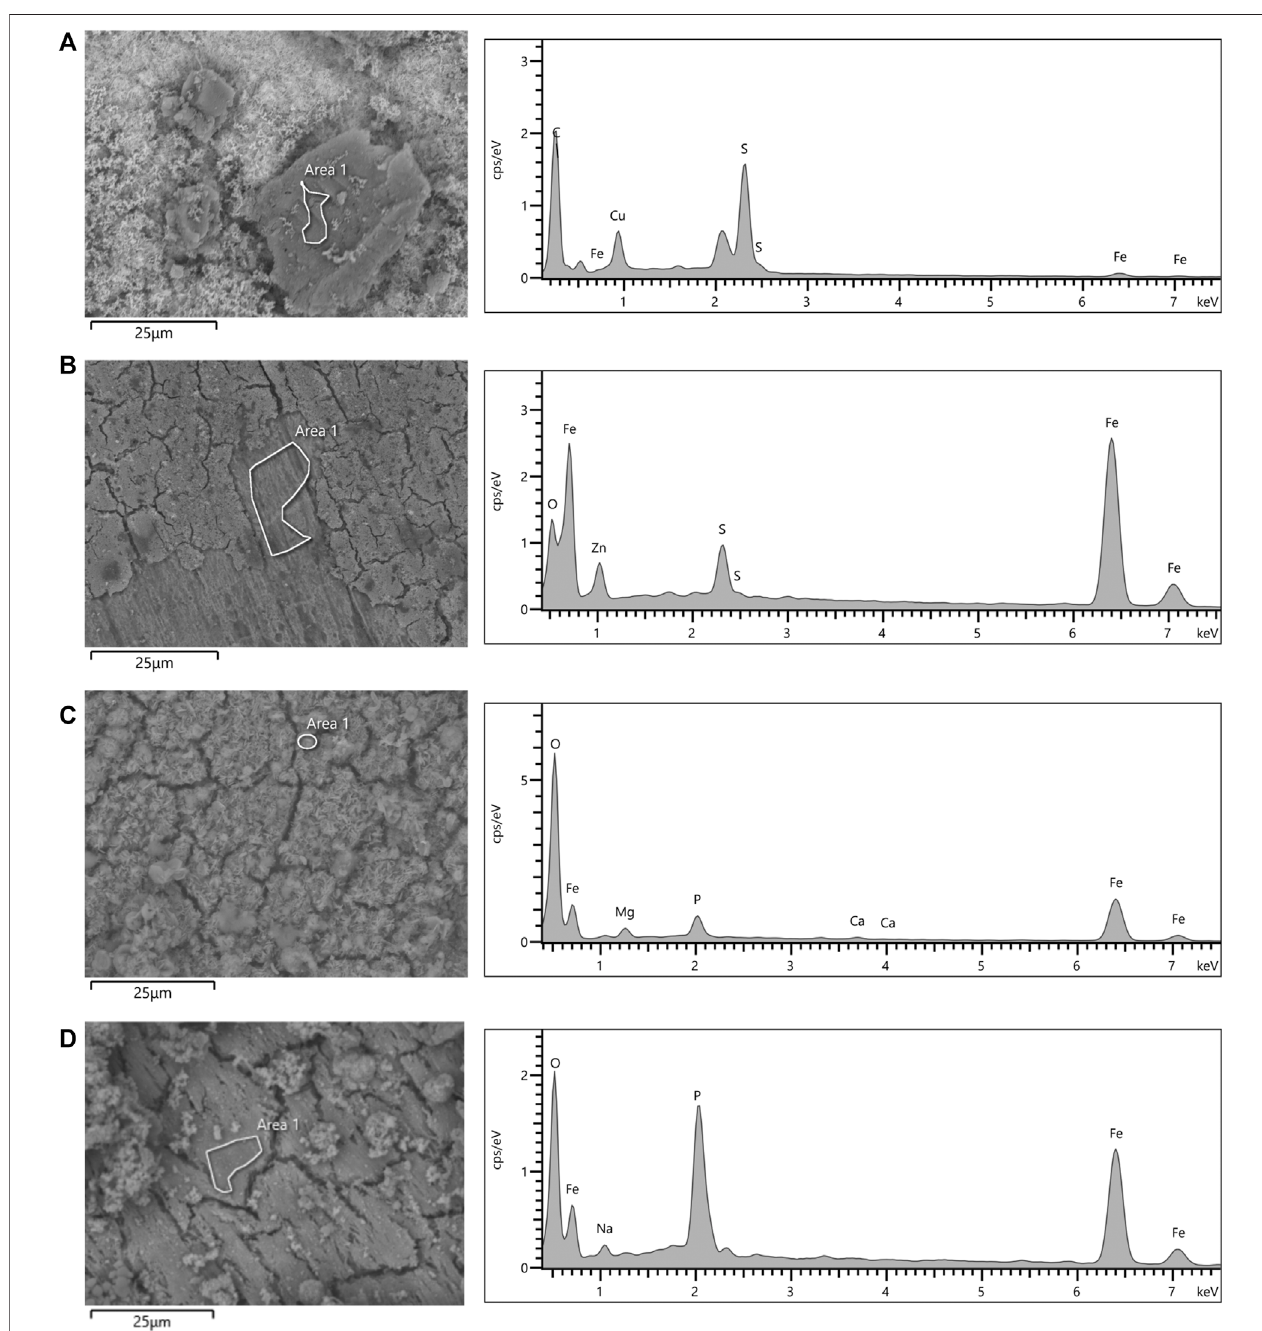
FIGURE8| SEMmicrographsand EDSspectraofcoupon ’ ssurfacesafter16-daysexposureto S.chilikensis (A,C) andsterilecontrols (B,D) tothiosulphate (A,B) and nitrate (C,D) reducing conditions.